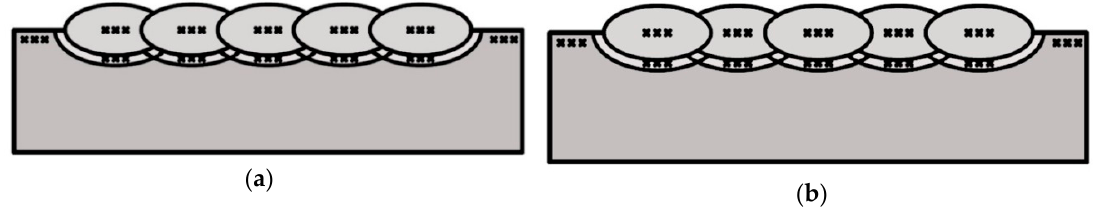
Figure 4. Hardness distribution points: ( a ) specimen S1, ( b ) specimen S2.